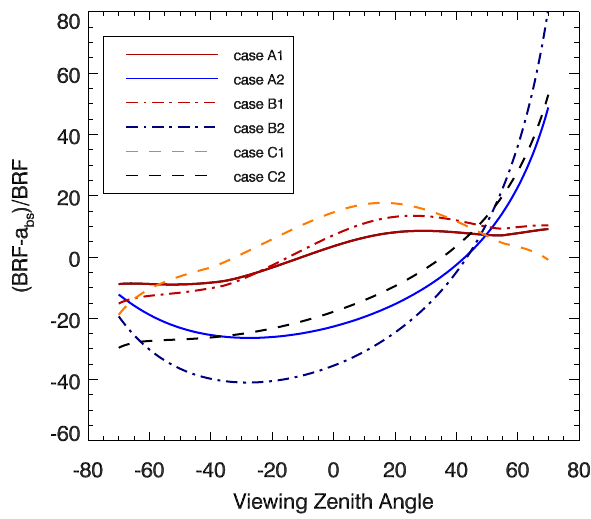
Fig. 6: Relative differences between BRF and black-sky albedo ( ) BRFaBRF Fig. 6. Relative differences between BRF and black-sky albedo OMI orbit marked in Fig. 5, and for the cases (A1, B1 and C1 are summer cases; A2, B2 and ( BRF − a bs )/ BRF for the OMI orbit marked in Fig. 5, and for the C2 are winter cases) listed in Table 1. cases (A1, B1 and C1 are summer cases; A2, B2 and C2 are winter cases) listed in Table